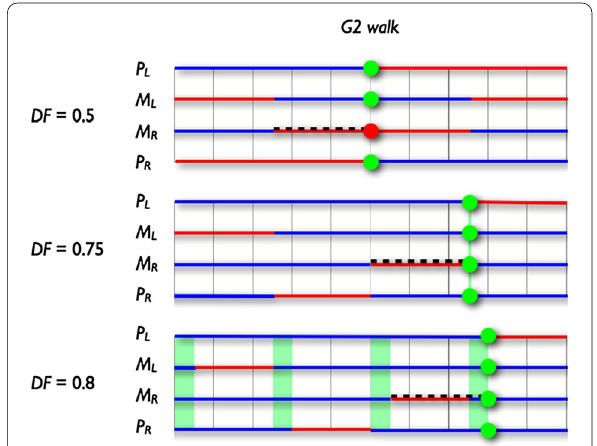
(2) Fig. 13 The step cycle for a G2 walk for three different duty factors ( DF ), with blue indicating support and red indicating transition states. We consider the case when P L finishes support, and examine the state of the other three locators. For DF moment, indicated by the colored dots, we see that only three of the four locators are in ground contact (green), while M R is in transition (red) and its location must be interpolated. For DF graphs) M R has completed its step and all four limbs are in ground contact. The dashed black line indicates the relative phase between M R and P